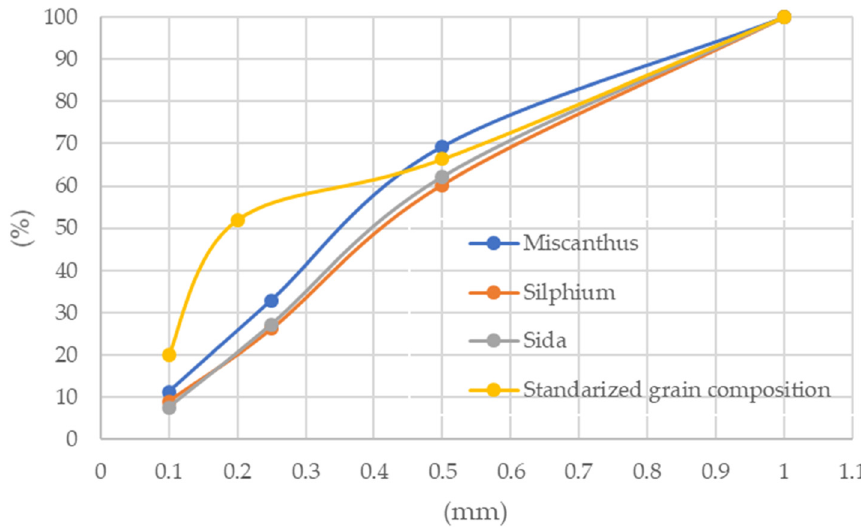
Figure 6. Cumulative particle size distribution.